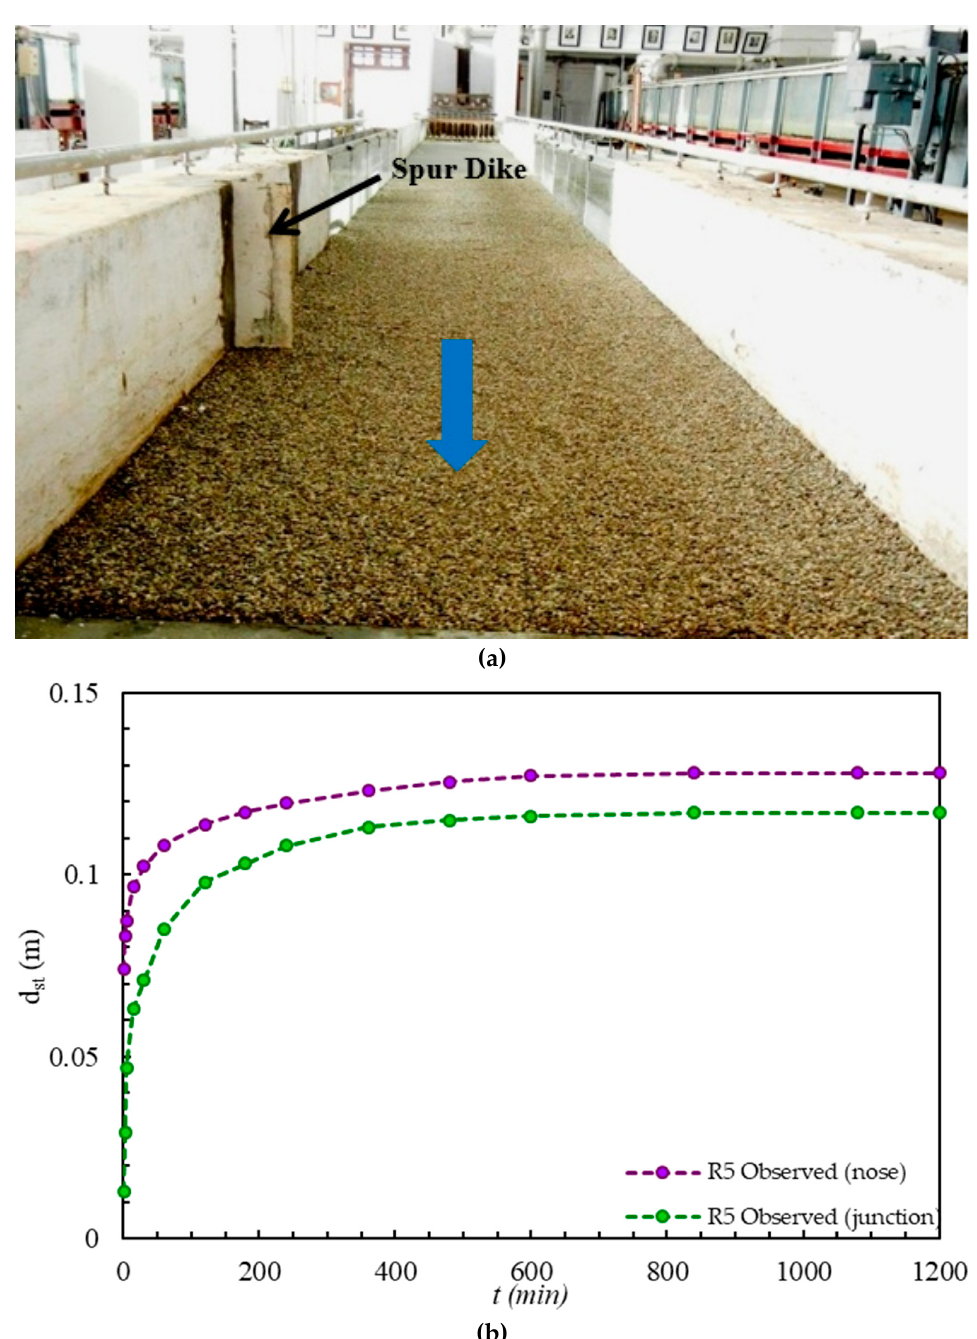
Figure 2. Experiments. ( a ) Photometric view. ( b ) Scour depth variations with time at upstream nose and wall-junction of the spur dike.